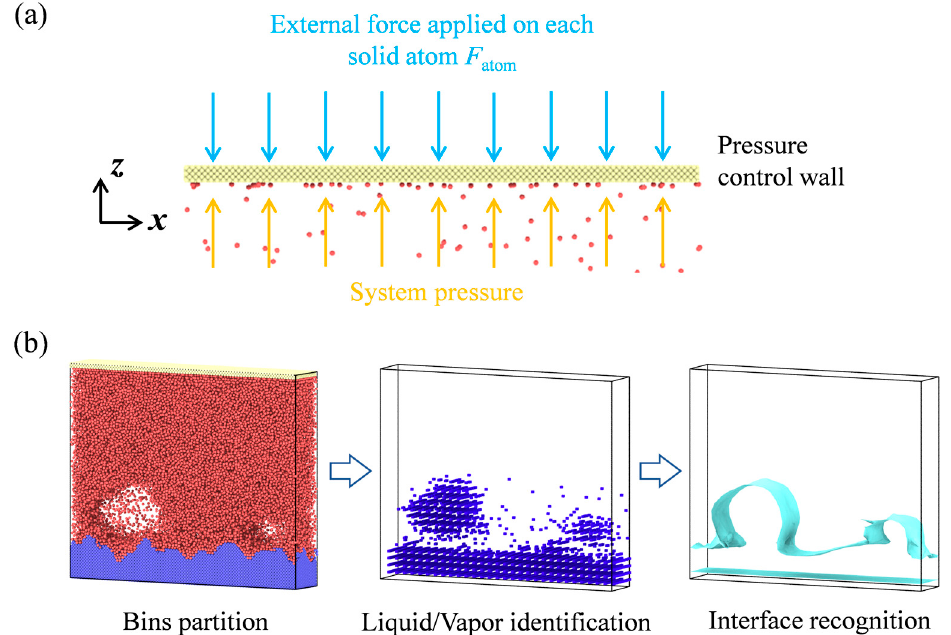
Figure 2. ( a ) Pressure control method; ( b ) Bubble identification.